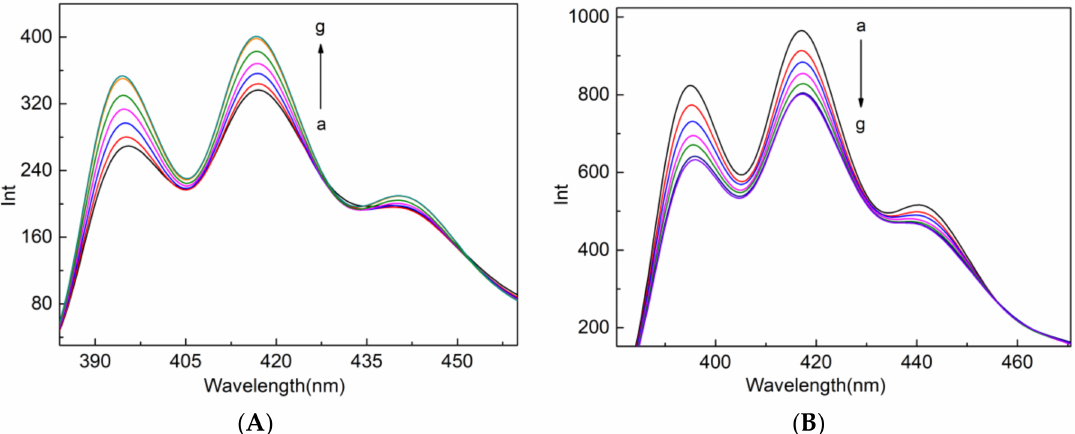
Figure 3. ( A ) Fluorescence spectra of the ABAM with addition of CB[7]: (a) 0; (b) 0.2 eq.; (c) 0.4 eq.; (d) 0.6 eq.; (e) 0.8 eq.; (f) 1.0 eq.; (g) 1.2 eq. ([ABAM] = 2 µ M, pH = 4.70, λ ex / λ em = 366/417 nm,